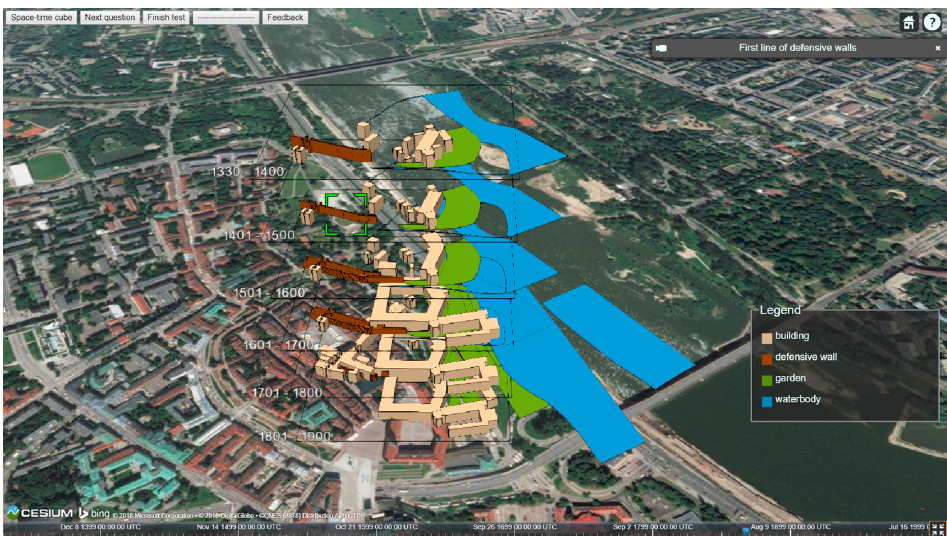
Figure 5. Interface of the space–time cube for the Royal Castle in Warsaw.